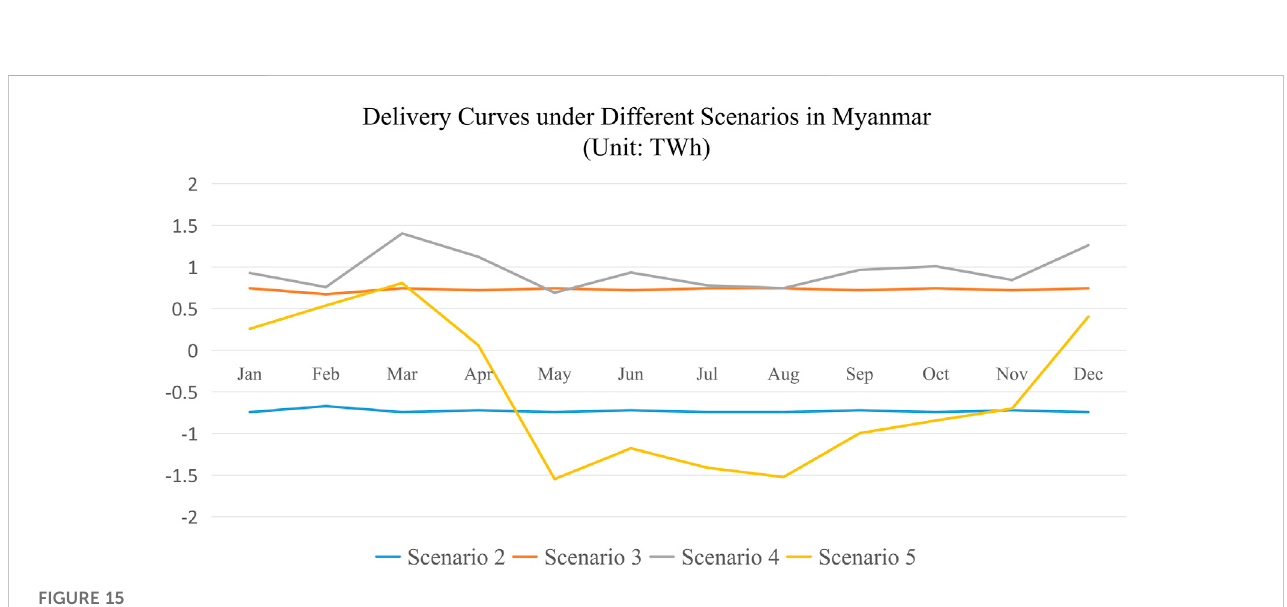
FIGURE 15 Delivery curves under different scenarios in